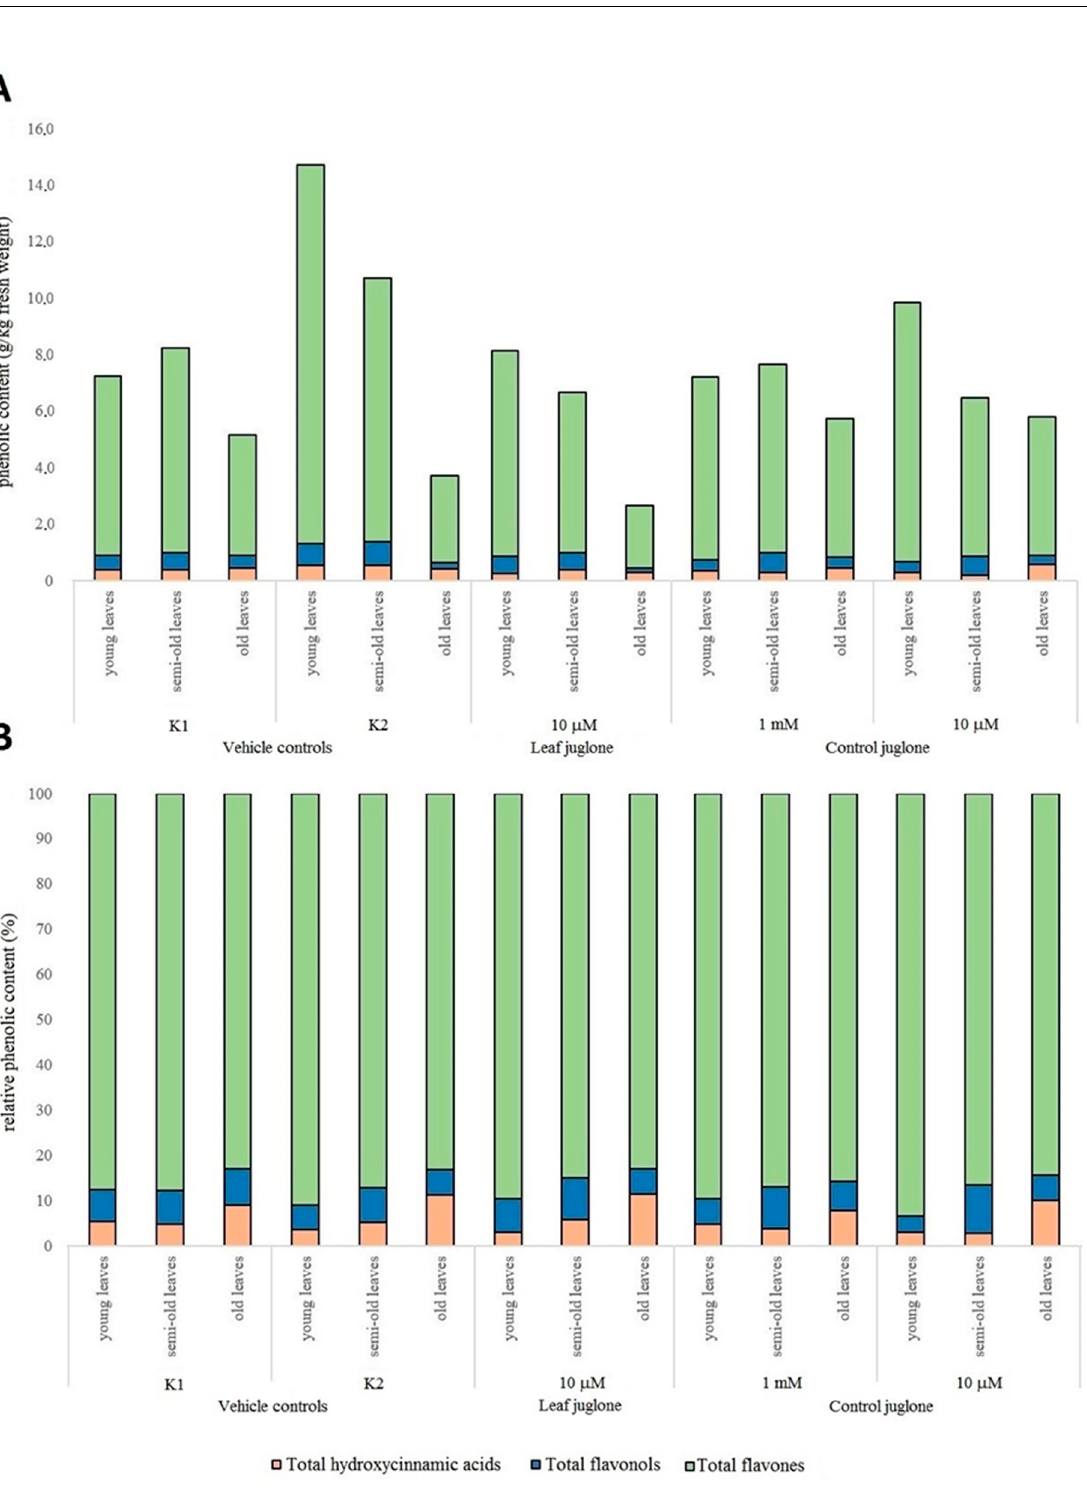
Figure 2. Contents of the total phenolic groups identified in B. vulgaris expressed relative to fresh weight ( A ) and as proportions of the total phenolic groups identified ( B ). K1: extraction medium control (0.17% DMSO, 0.17% ethanol in H 2 O); K2: water control. Young leaves, undeveloped leaves; semi-old leaves, remaining fully developed leaves; old leaves, four outer fully developed leaves.